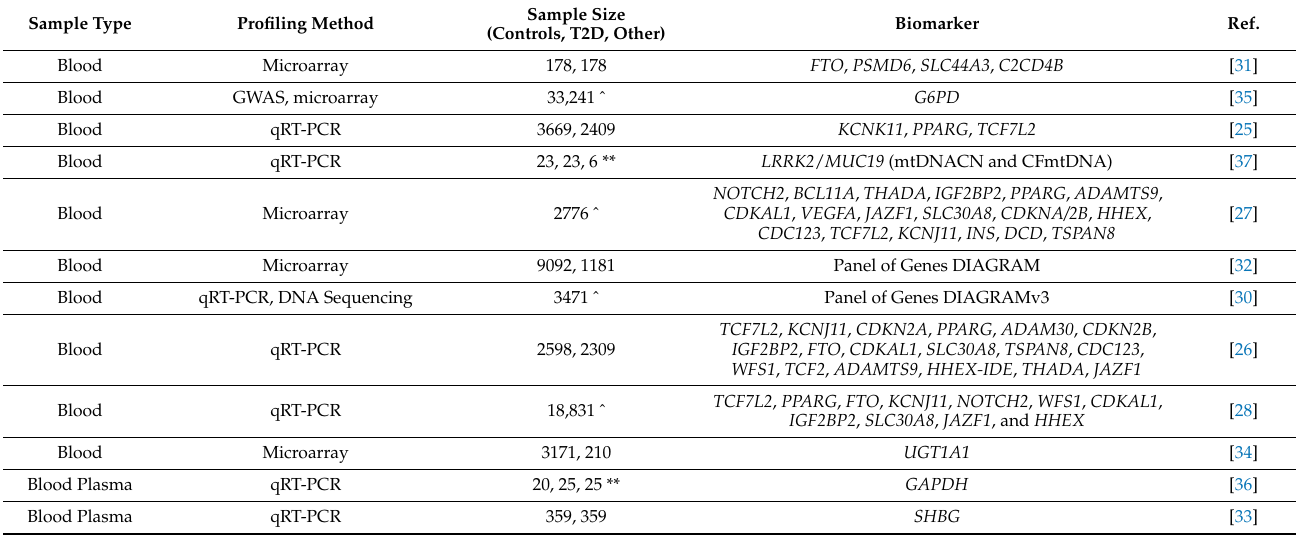
Table 2. Genomics biomarkers from blood samples for T2D.